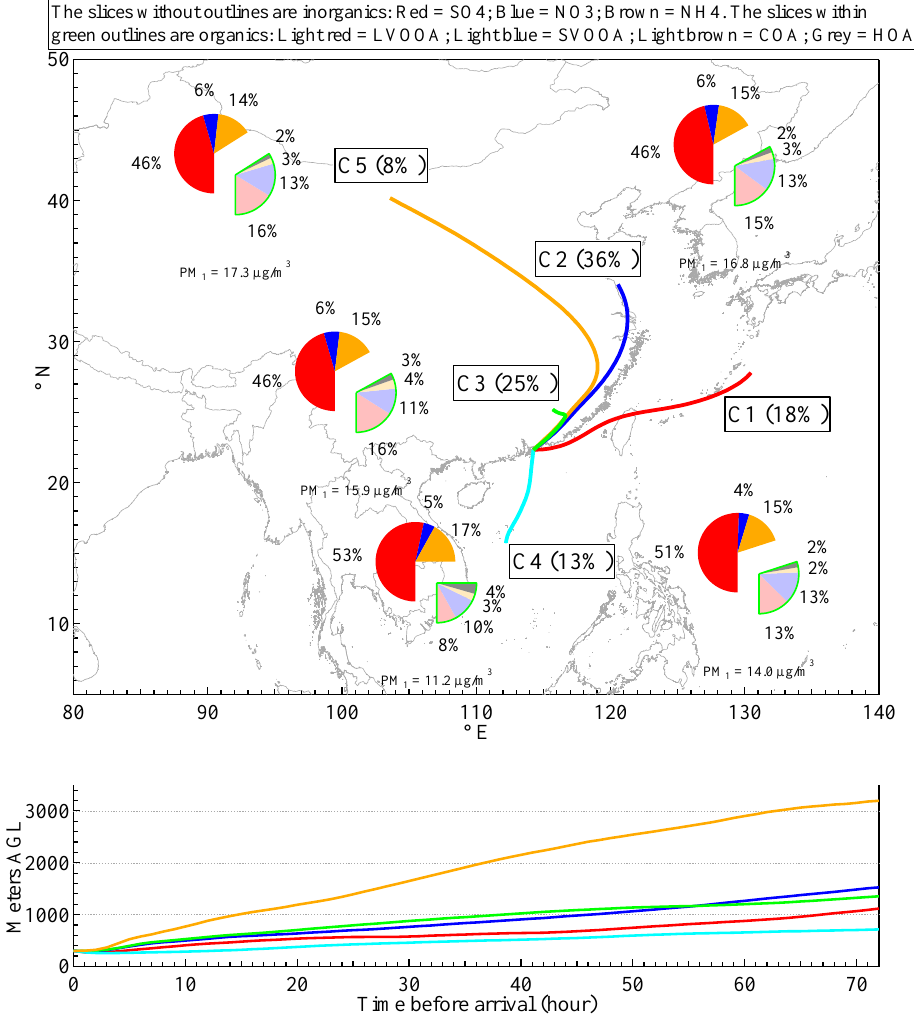
Figure 7. Average fractions of sulfate, ammonium, nitrate, and organics with PMF-resolved LVOOA, SVOOA, COA, and HOA in different Figure 7 Average fractions of sulfate, ammonium, nitrate and organics with PMF-resolved LVOOA, 2 clusters from the five-cluster solution at 300m arrival height (AGL: above ground level). The colored lines in the upper panel show the average trajectories, and the corresponding colored lines in the lower panel show the vertical profiles of those SVOOA, COA, and HOA in different clusters from the 5-cluster solution at 300 m arrival height (AGL 3 = above ground level). The color lines in the upper panel show the average trajectories and the 4 corresponding color lines in the lower panel show the vertical profiles of those trajectories. 5